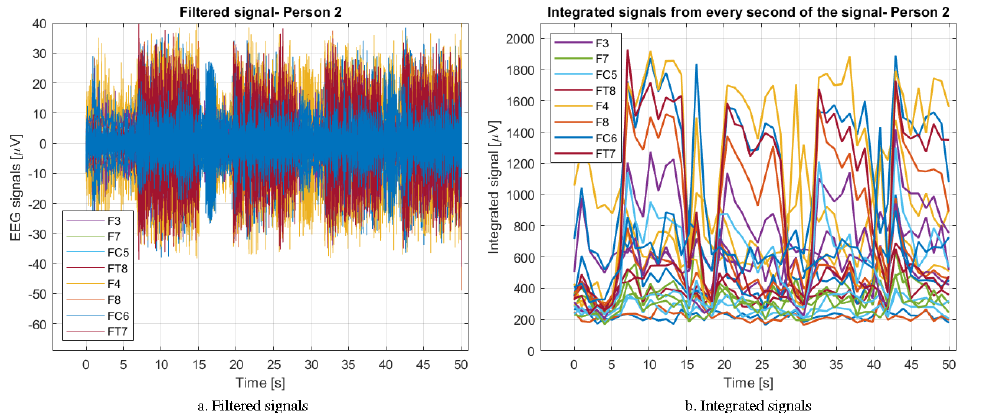
Figure 7. Comparison of filtered and integrated signals—Person 2.